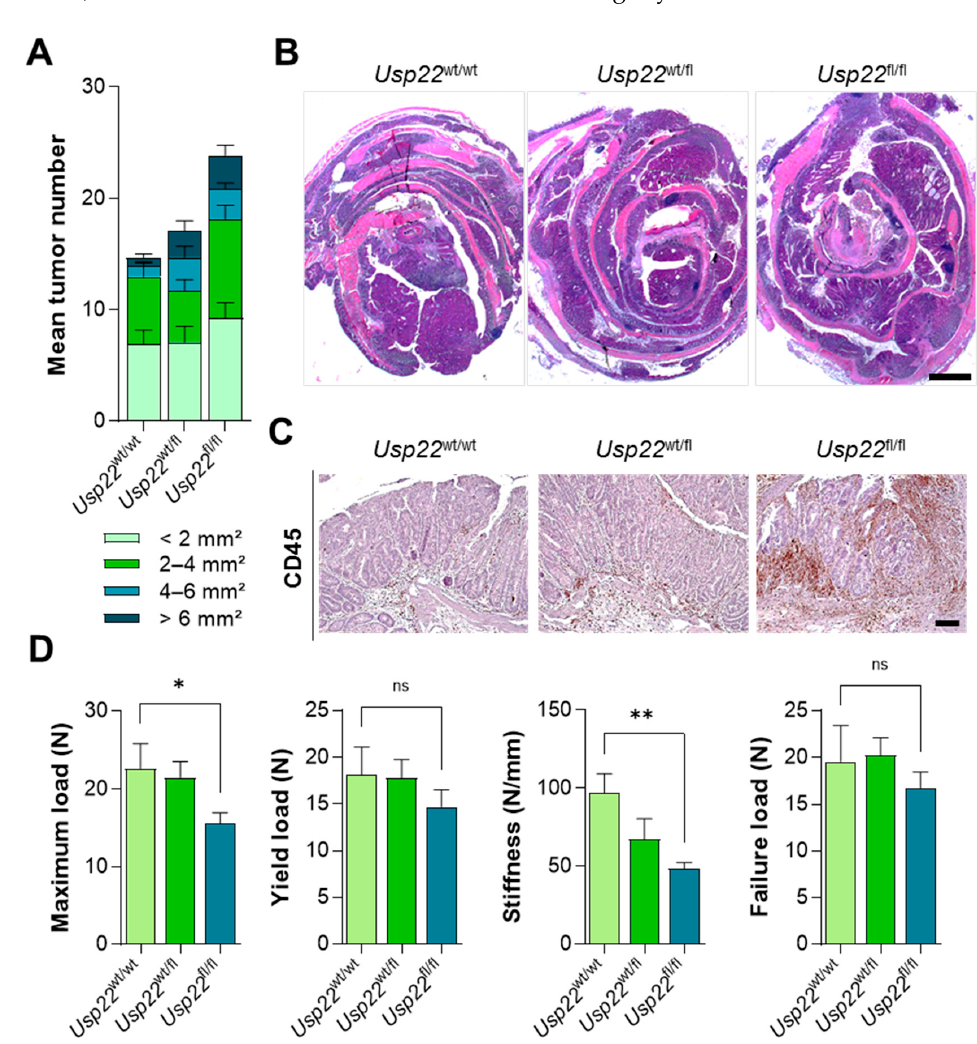
Figure 4. Colorectal tumor burden is increased in Apc -mutant mice with an intestinal Usp22 deletion. ( A ) In Villin-CreER T2 mice carrying an Apc 1638N/+ mutation, a conditional Usp22 deletion led to increased tumor number and size following DSS treatment. ( B ) Representative images of H&E-stained colons isolated from Apc 1638N/+ , Villin-CreER T2 , Usp22 flox mice. Scale bar: 1 mm. ( C ) IHC revealed increased infiltration of CD45-positive cells into colorectal tumors of Usp22 -deleted mice. Scale bar: 100 μ m. ( D ) Increased bone fragility was detected in Apc 1638N/+ , Villin-CreER T2 , Usp22 fl/fl mice using biomechanical analyses of tibiae. Mean ± SEM. One-way ANOVA. * p ≤ 0.05, ** p ≤ 0.01.